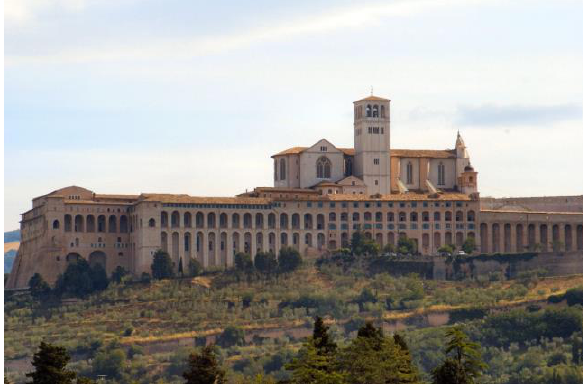
Figure 1. Panoramic view of the Papal Basilica and the Sacred of Assisi